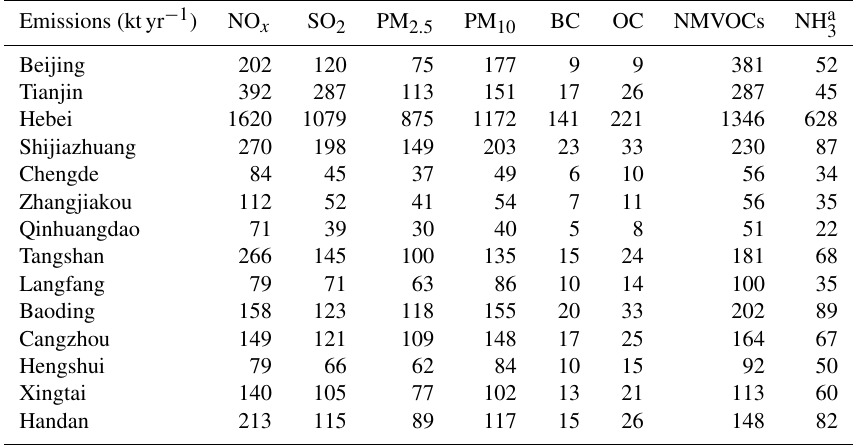
Table 1. Summary of the emissions of major pollutants in Beijing, Tianjin and 11 prefecture-level cities in Hebei in